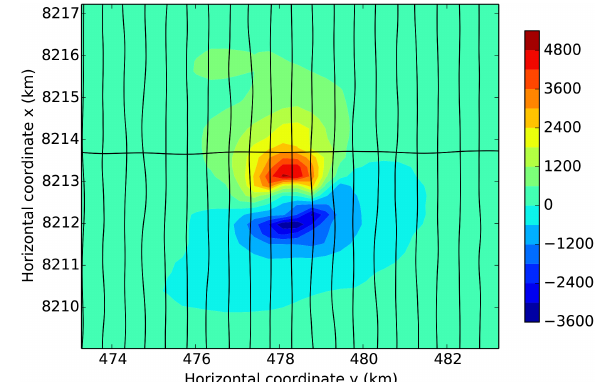
Figure 15. Application to field data on the Goiás alkaline province (GAP), Brazil. Total-field anomaly observed over the area delimited by the red rectangle in Fig. 14. The flight lines of the aeromagnetic survey are shown in black. The magnetic data are in nT and the co- ordinates are in UTM on the SAD-69 datum, with central meridian 51 ◦ W. The origins of the eastern and northern coordinates are 500 and 10000km, respectively.